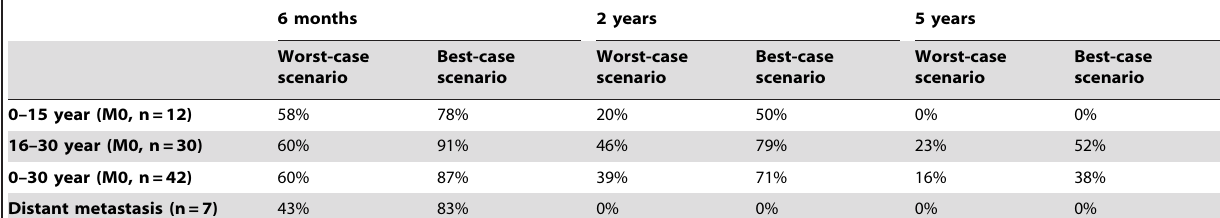
Table 4. Overall